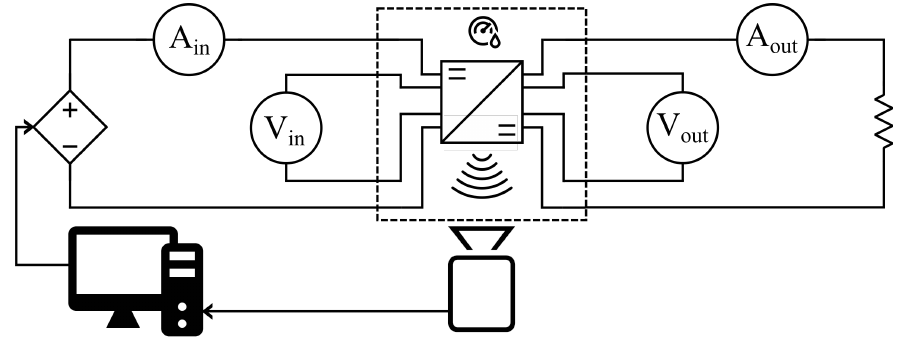
Figure 7. Schematic of the experimental setup used to fine-tune and validate the electro-thermal DC–DC converter model.